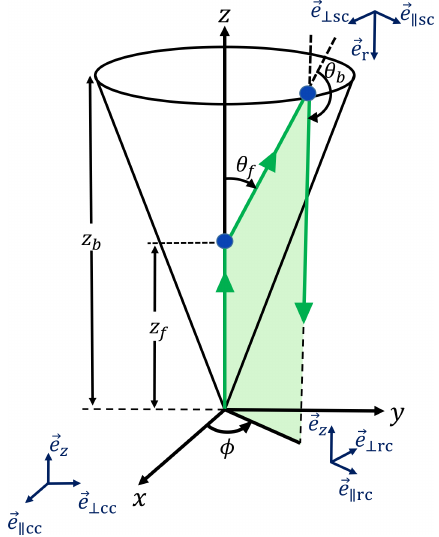
Figure 1. Scattering geometry for one forward and one backward scattering